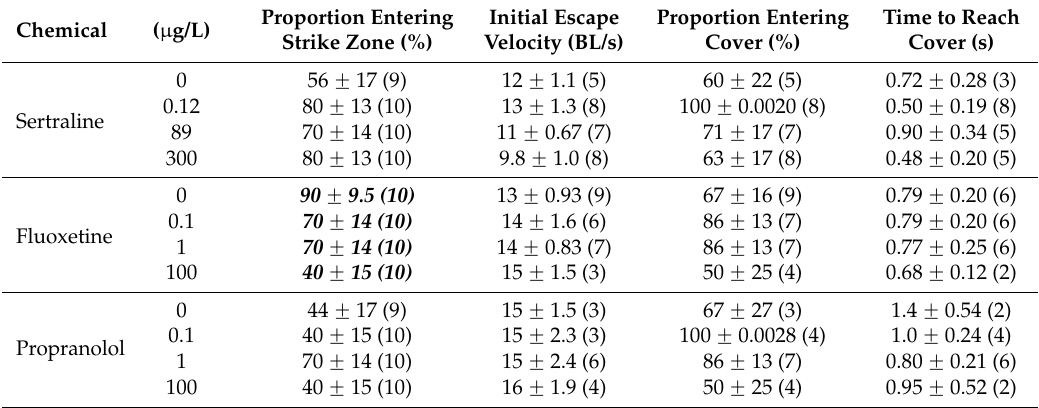
Table 1. Means ± SEM ( n ) of assayed behavioral endpoints for sertraline, fluoxetine, and propranolol treatments. Values for proportions entering strike zone and cover are predicted GLM means ± SEM. Statistically significant GLM results are presented in bold italics.